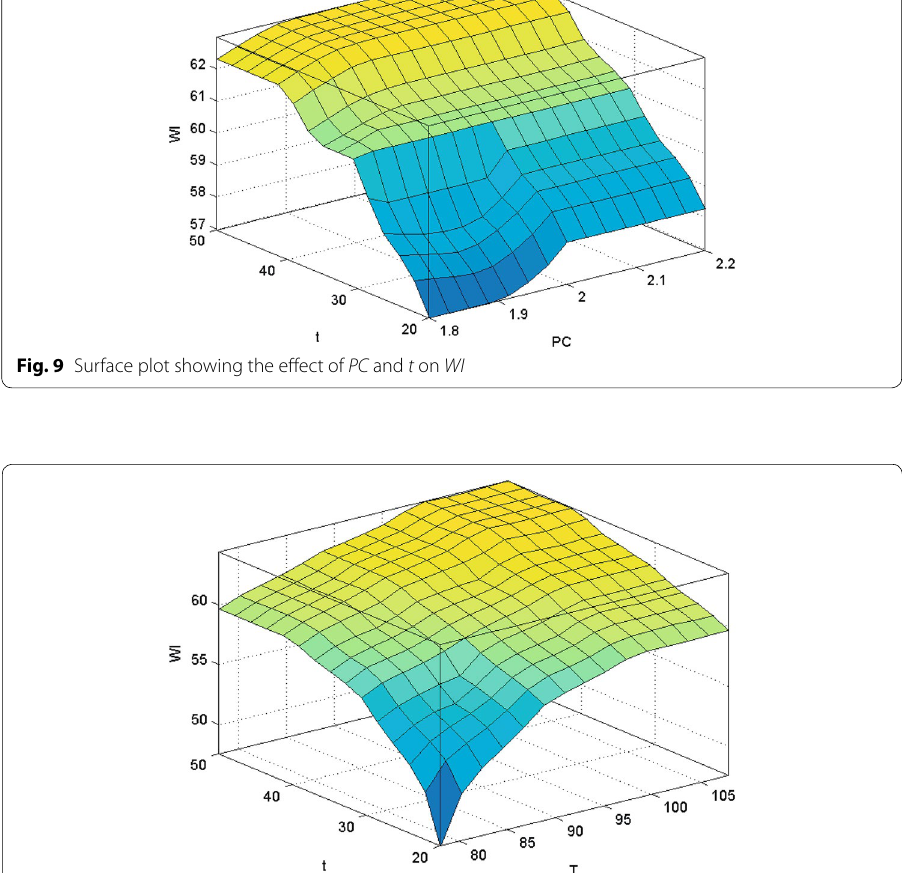
Fig. 10 Surface plot showing the effect of t and T on